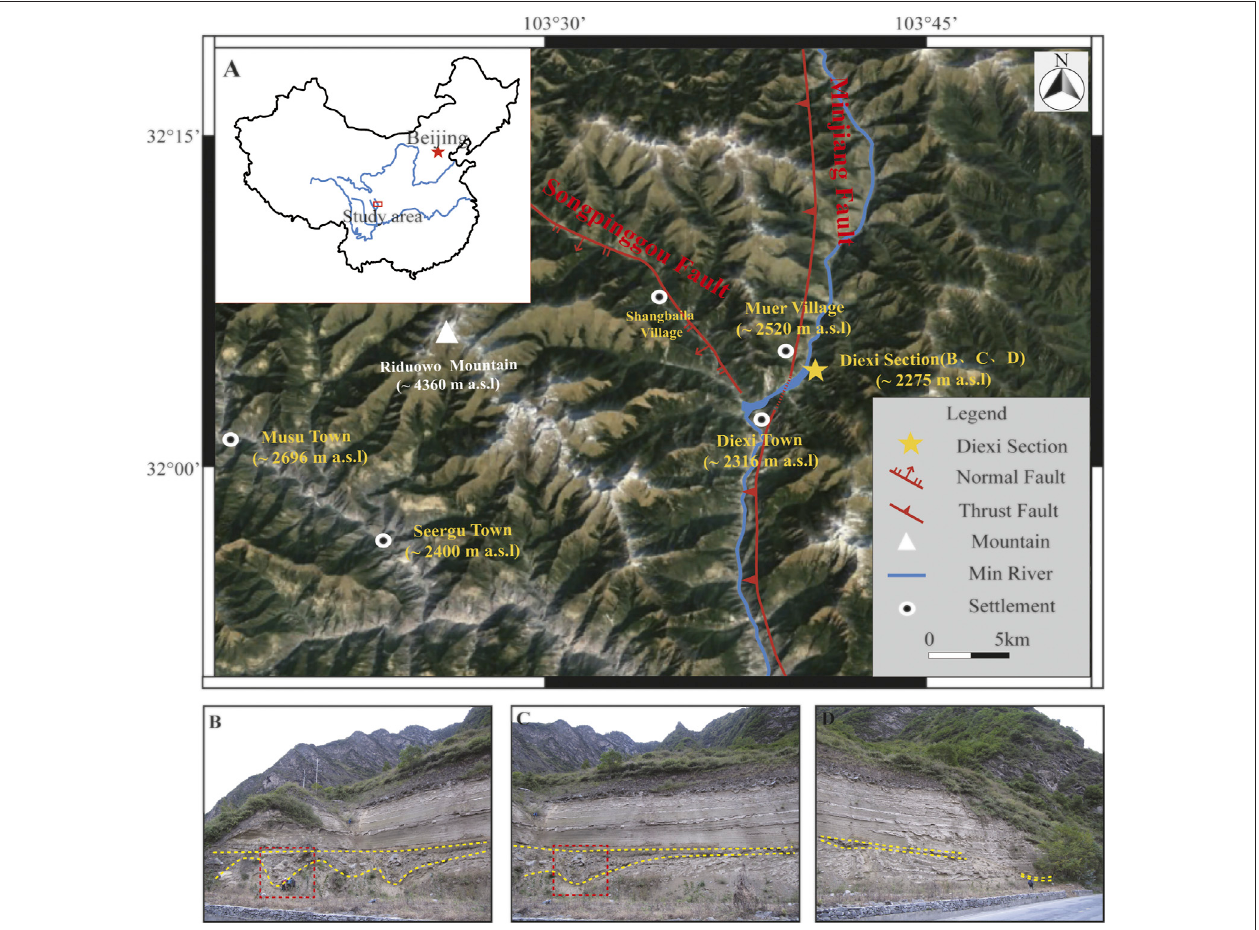
FIGURE 1 | (A) Diexi lacustrine section close to Diexi town, where the Songpinggou fault and Minjiang fault converge; (B) Northern part of the section, and the red dotted line represents the position of Figure 4B ; (C) Central part of the section, and the red dotted line represents the position of Figure 4A ; (D) Southern part of the section.